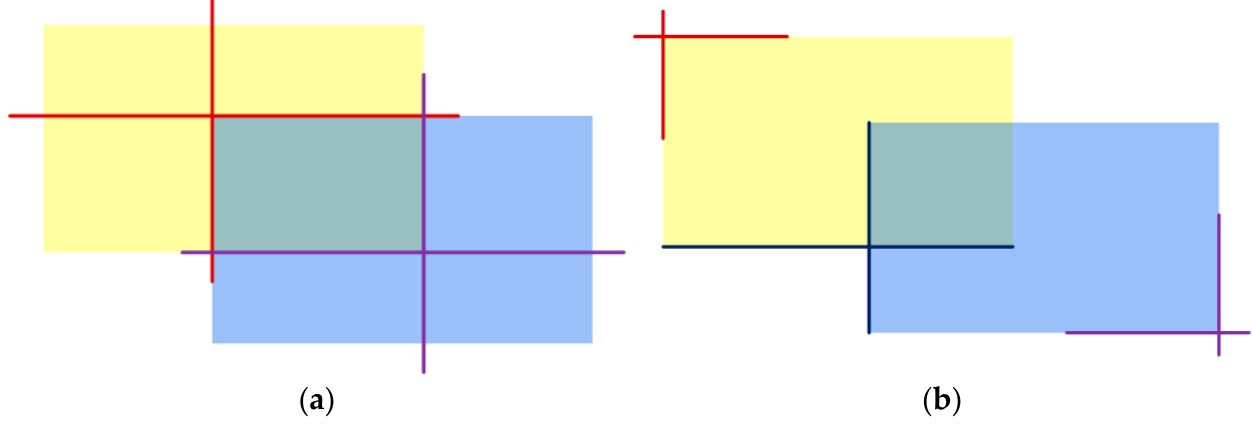
Figure 8. Diagram of the prediction and target boxes. ( a ) The width and height of the intersection area is obtained from the difference of the specified points. ( b ) The width and height of the closure area is obtained from the difference of the specified points.